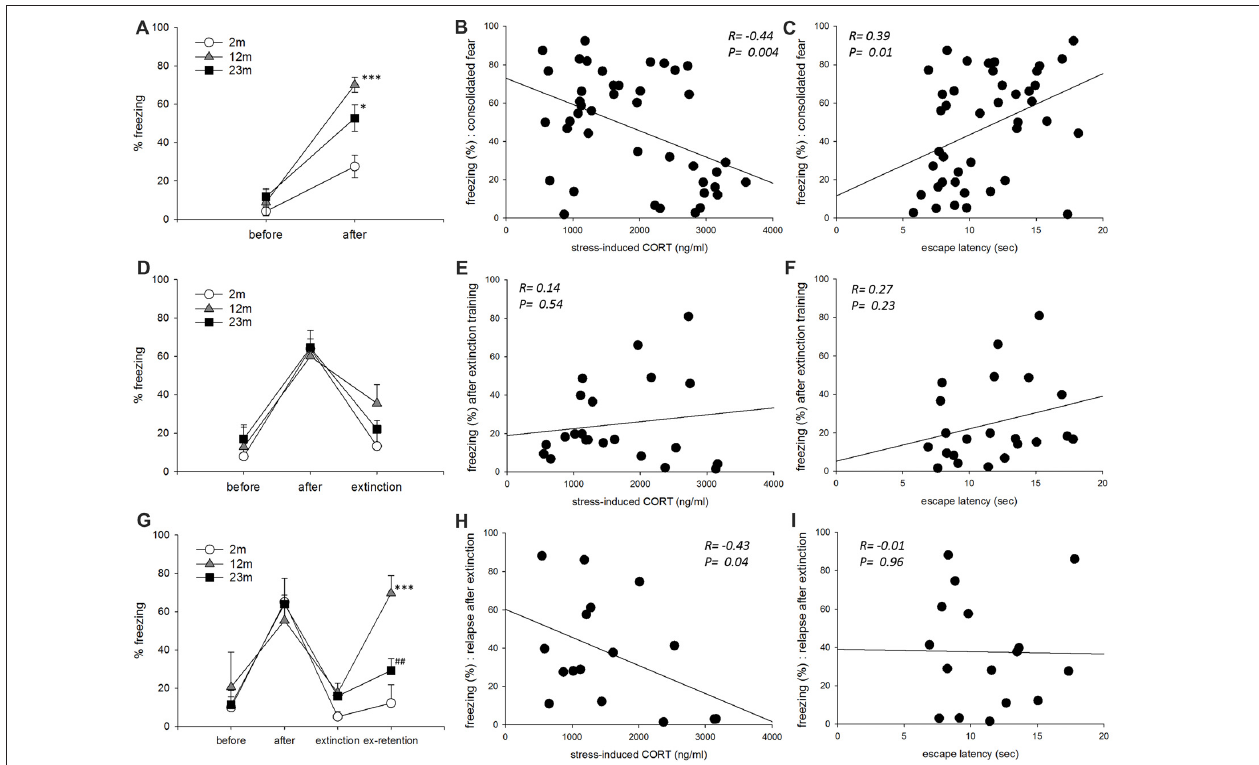
FIGURE 4 | The influence of age, stress reactivity and coping style on conditioned fear. (A) Conditioned contextual fear consolidation. Repeated measures ANOVA showed a significant before-after training effect ( F ( 1,39 ) = 78.9, p < 0.001), age effect ( F ( 2,39 ) = 11.2, p < 0.001), and training by age interaction ( F ( 2,39 ) = 5.1, p = 0.011). By pairwise comparisons, 12-month-old ( p < 0.001) and 23-month-old ( p = 0.011) mice froze more often than 2-month-old mice (2 month, n = 17; 12 month, n = 11; 23 month, n = 14). (B) Correlation between stress-reactivity (stress-induced corticosterone concentration) and conditioned fear consolidation. (C) Correlation between coping style (escape latency in the active avoidance test) and conditioned fear consolidation. (D) Conditioned fear extinction. Only mice that froze more than 50% after training were included. Repeated measures ANOVA revealed a significant before-after training effect ( F ( 2,38 ) = 34.7, p < 0.001) but no significant age effect ( F ( 2,19 ) = 0.59, p = 0.57) or training by age interaction ( F ( 4,38 ) = 0.86, p = 0.47) (2 month, n = 5; 12 month, n = 8; 23 month, n = 9). (E) Correlation between stress-reactivity (stress-induced corticosterone concentration) and conditioned fear extinction. (F) Correlation between coping style (escape latency in the active avoidance test) and conditioned fear extinction. (G) Conditioned fear extinction retention. Only mice that froze less than 20% after extinction training were included. Repeated measures ANOVA revealed a significant before-after training effect ( F ( 3,39 ) = 23.9, p < 0.001), age effect ( F ( 2,13 ) = 4.37, p = 0.035) and training by age interaction ( F ( 6,39 ) = 3.13, p = 0.013). By pairwise comparisons, 12-month-old mice froze more than 2-month-old mice ( p = 0.001), and 23-month-old mice froze less than 12-month-old mice ( p = 0.007) (2 month, n = 4; 12 month, n = 5; 23 month, n = 7). (H) Correlation between stress-reactivity (stress-induced corticosterone concentration) and relapse of extinct fear. (I) Correlation between coping style (escape latency in the active avoidance test) and relapse of extinct fear. All data are the mean ± SEM. 2 mo: 2-month old, 12 mo: 12-month old, 23 mo: 23-month old. ∗ p < 0.05, ∗∗∗ p < 0.001 vs. 2 mo, ## p < 0.01 vs. 12